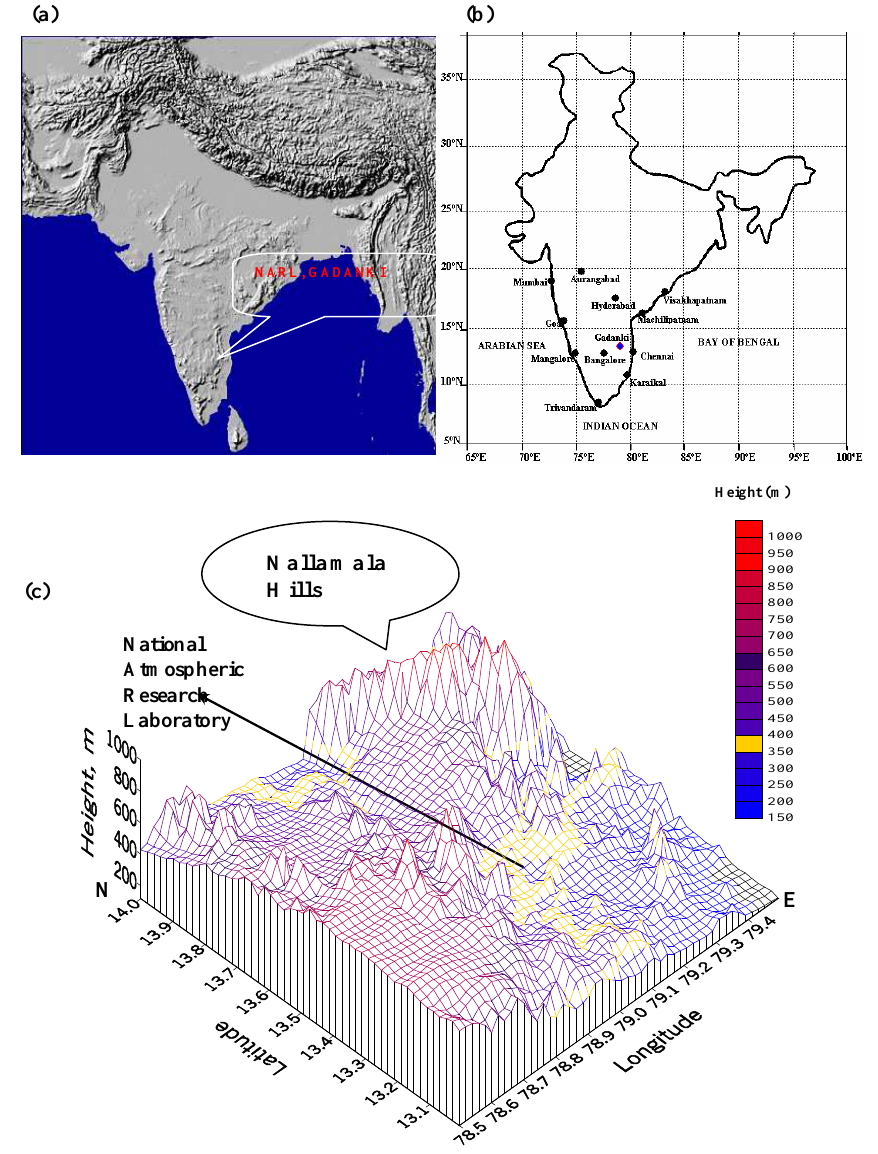
Fig. 1. (a) Geographical location of NARL, Gadanki (b) Location of Gadanki and southern IMD stations (c) Three-dimensional view of the main topography around Gadanki (after Krishna Reddy et al.,